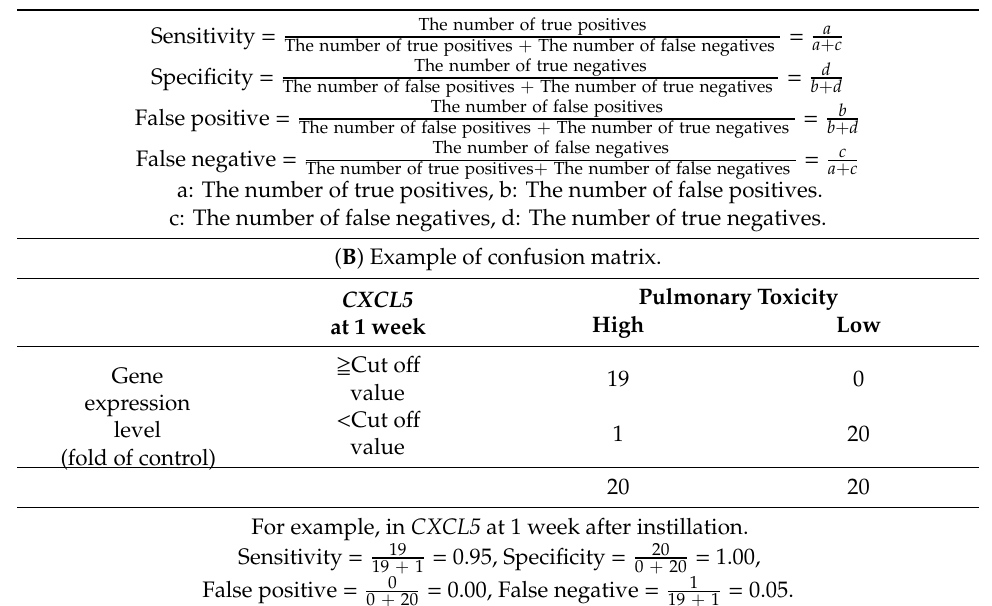
Table A1. ( A ) Confusion matrix. ( B ) Example of confusion matrix.